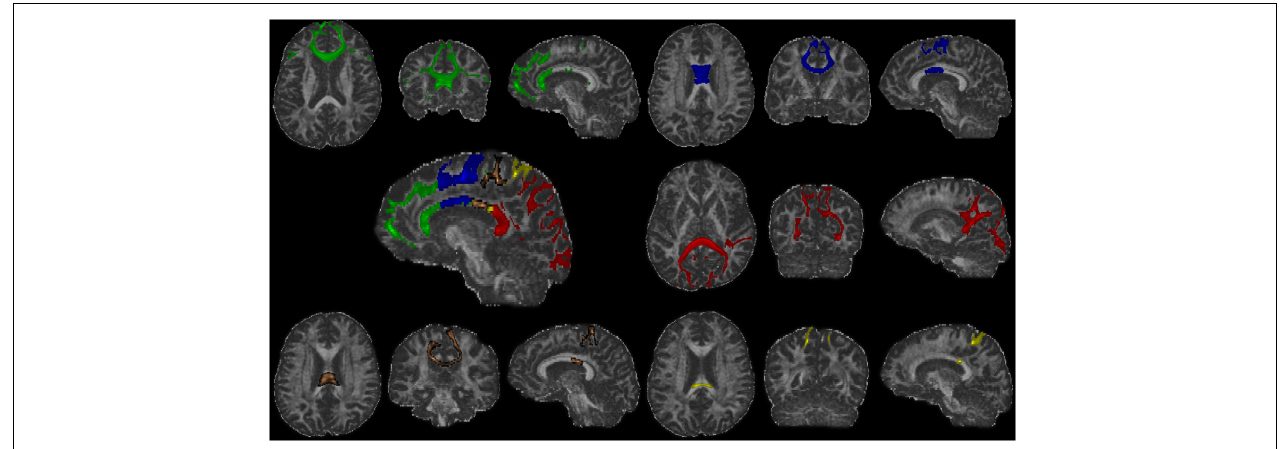
FIGURE 2 | The fiber tracts of each callosal subsections (one representative subject). Green, the prefrontal subsection tract; blue, the premotor subsection tract; orange, the motor subsection tract; yellow, the somatosensory subsection tract; red, the temporal–parietal–occipital subsection tract.